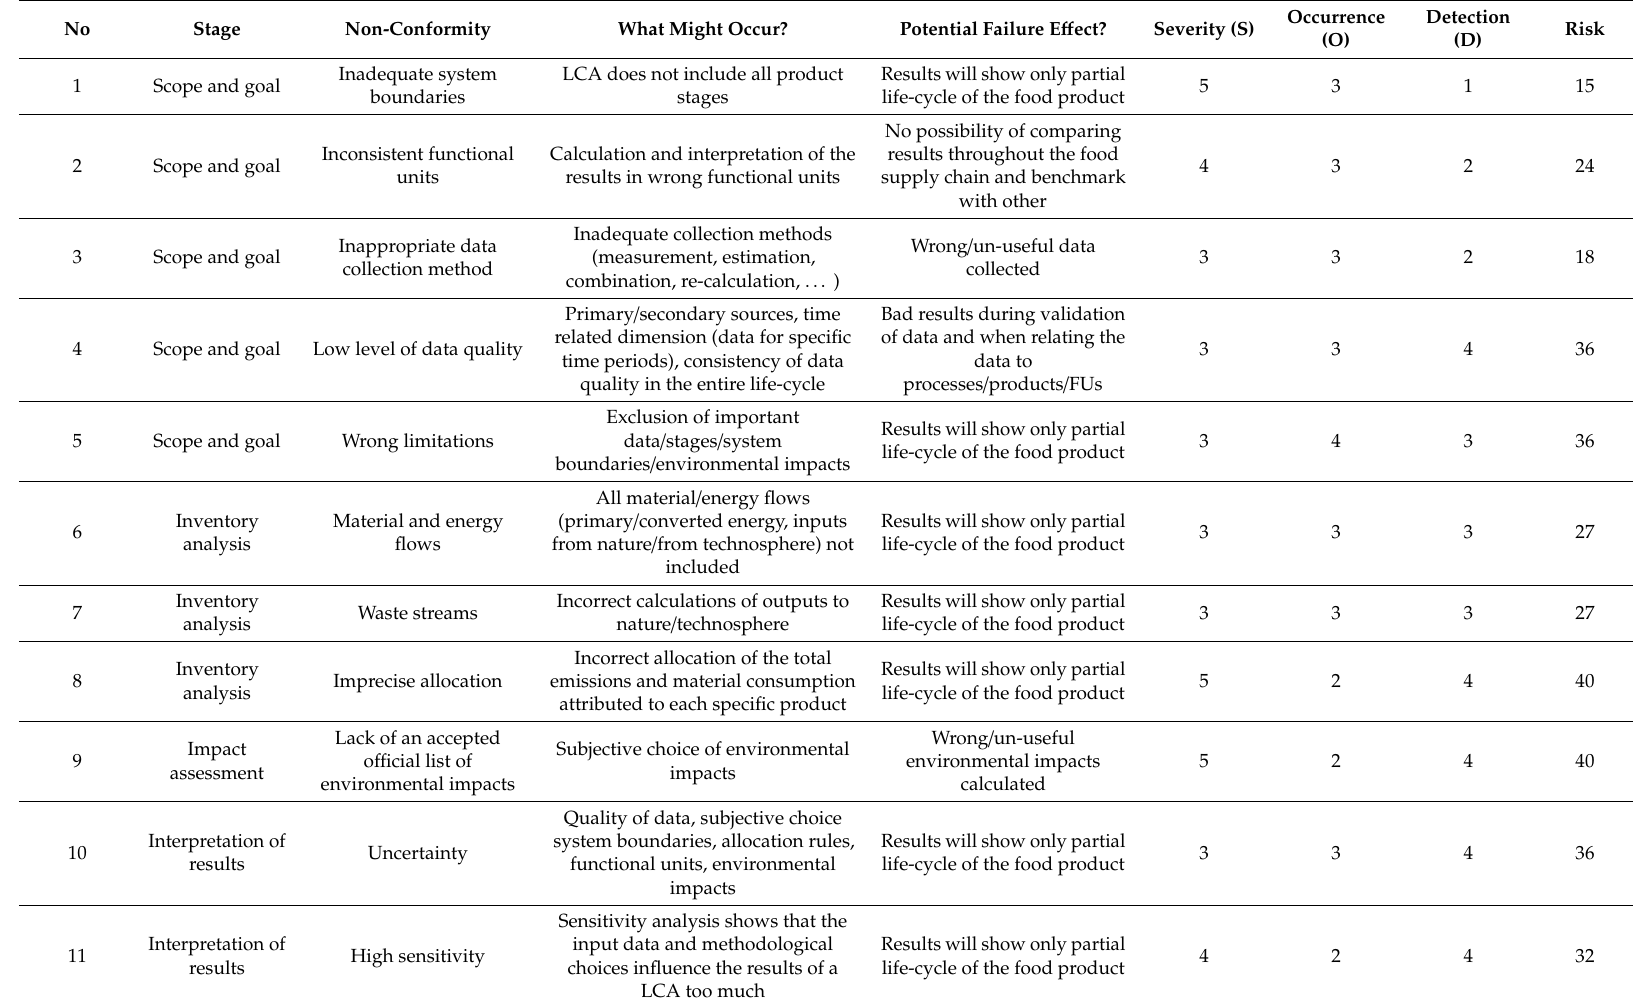
Table 2. Failure Mode and E ff ect Analysis of LCA of